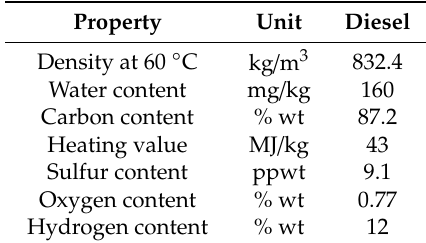
Table 1. Properties of the diesel used in this study.